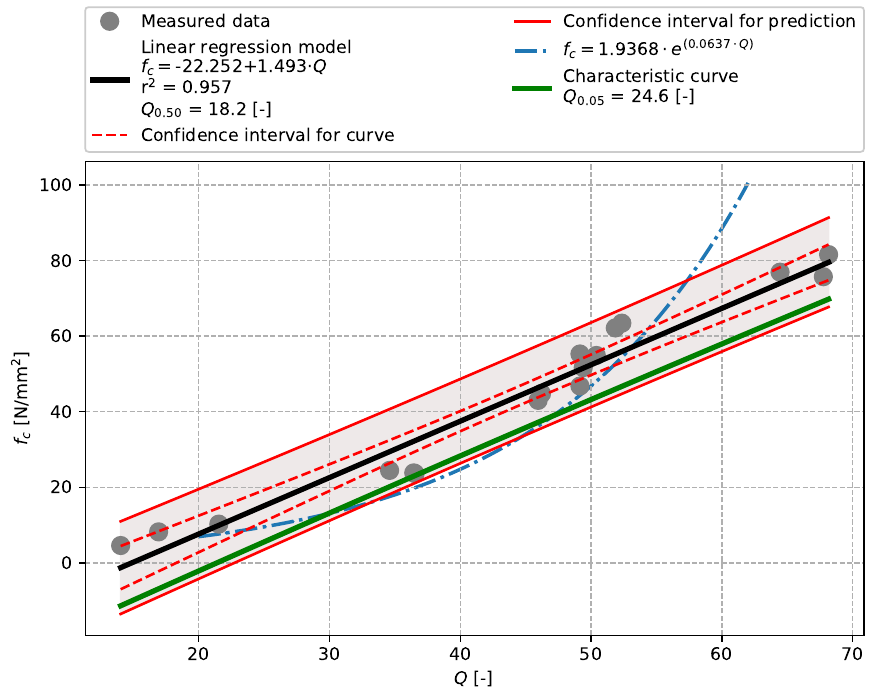
Figure 9. Precast concrete described in Section 3.2—model of the dependence of Q -value [-] vs. compressive strength f c [N/mm 2 ]—SilverSchmidt L.